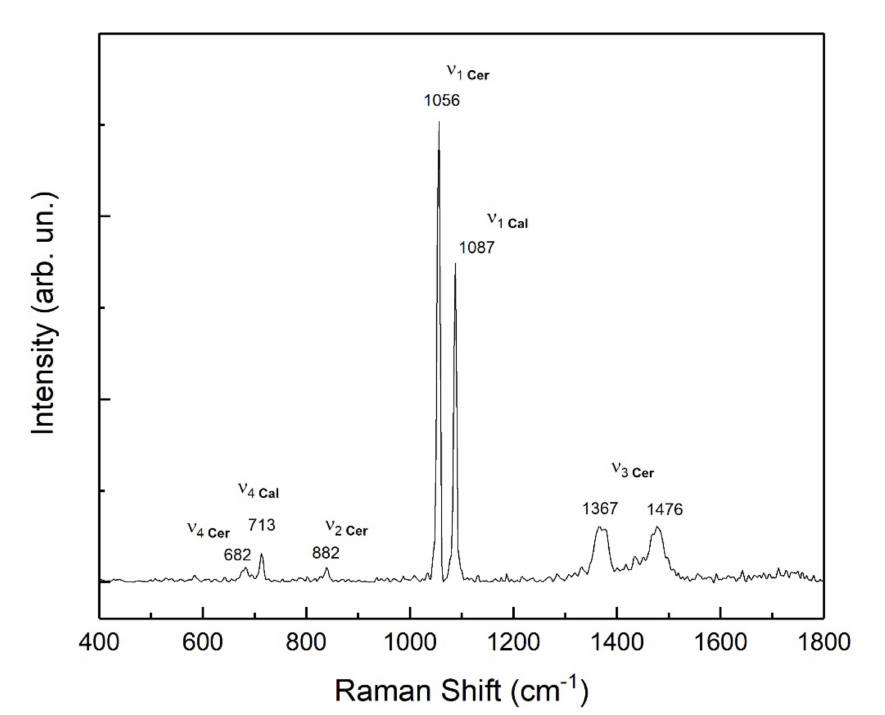
Figure 9. Raman spectra of the precipitate formed on a calcite crystal interacting with Pb-bearing solutions ([Pb] i = 1 mM). All bands can be assigned to vibration modes to either cerussite (Cer) or calcite